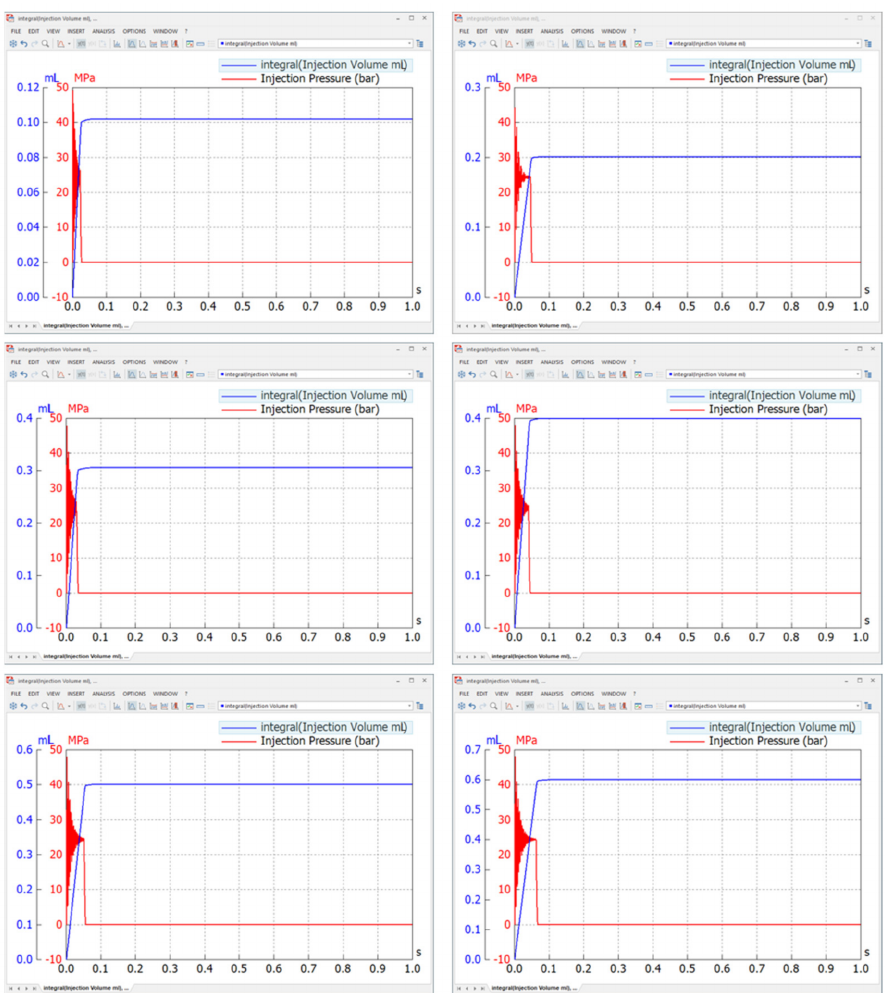
Figure 13. Results for injection volume control obtained through modeling of the NFI using Simula- tionX